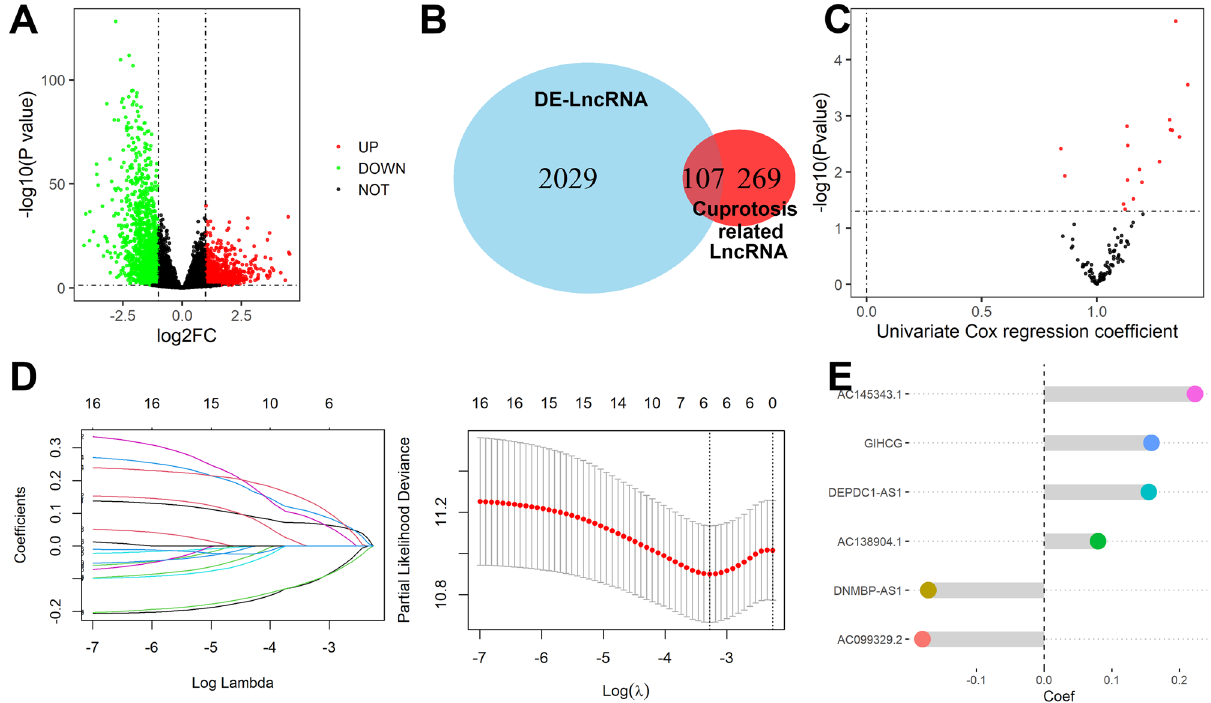
Figure 2. Identification of Cuproptosis-associated DE-lncRNAs. ( A ) DE-lncRNA in TCGA and GTEx database. ( B ) Cuproptosis-related lncRNA by Pearson correlation analysis. ( C ) 107 overlapping lncRNA were considered Cuproptosis-associated DE-lncRNAs. ( D ) lncRNAs screened by the LASSO-Cox regression model. ( E ) The multivariate Cox relapse